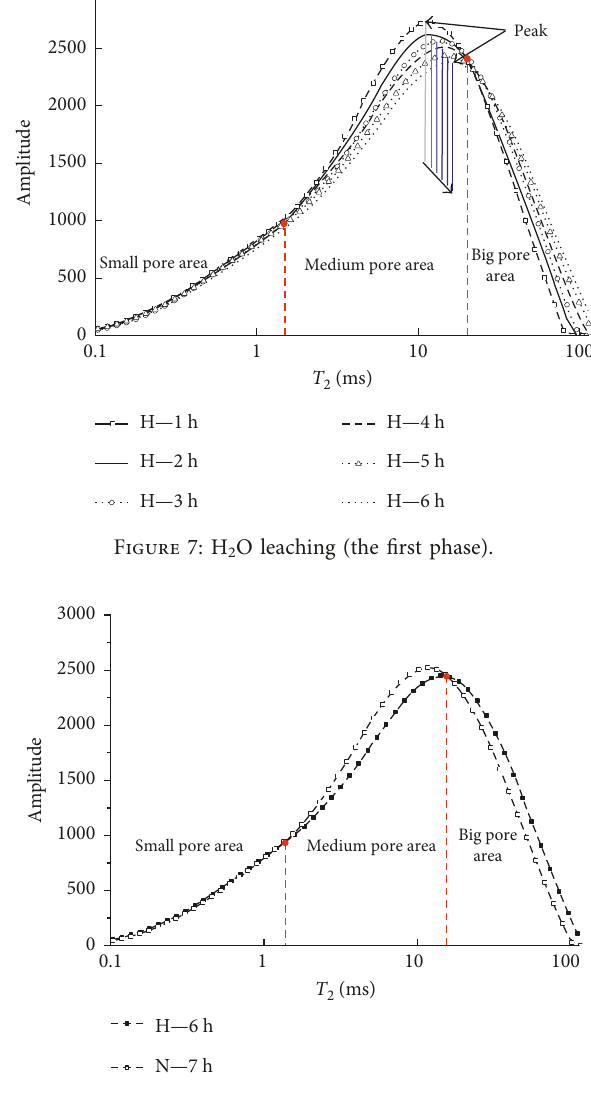
Figure 8: Transition phase of H phase).